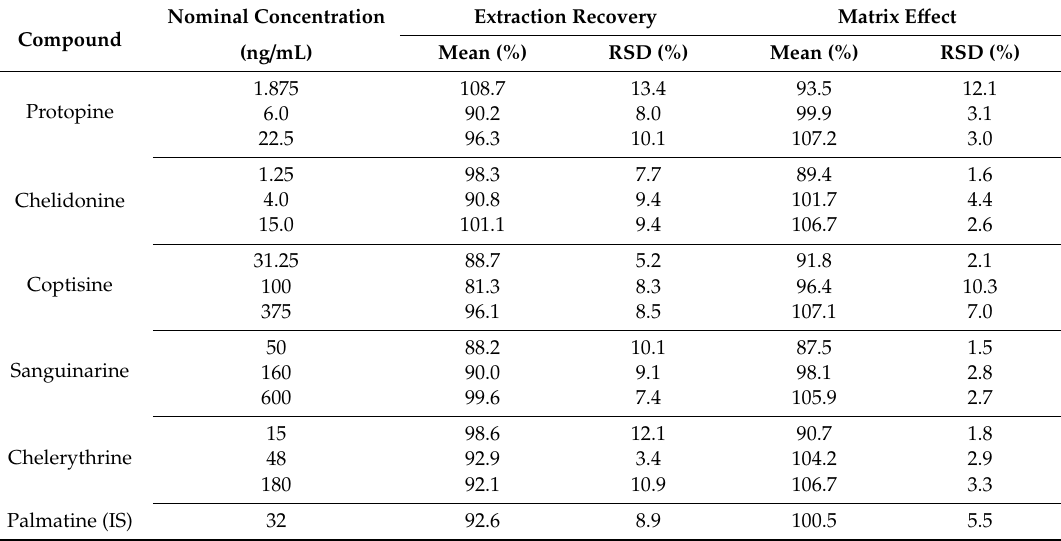
Table 3. Extraction recovery and matrix e ff ect of five alkaloids and IS in cell lysates for LC–MS / MS analysis.